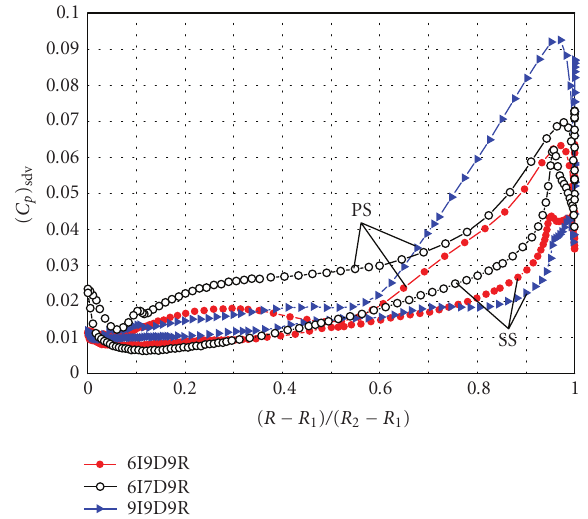
Figure 13: Comparison of pressure fluctuation on the impeller blade for three blade number configurations, midspan.